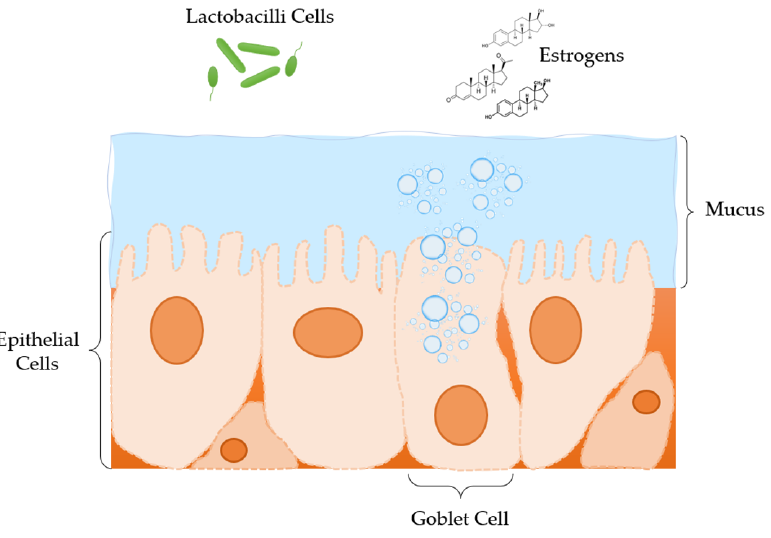
Figure 1. Anatomical and physiological features of the vagina microenvironment.